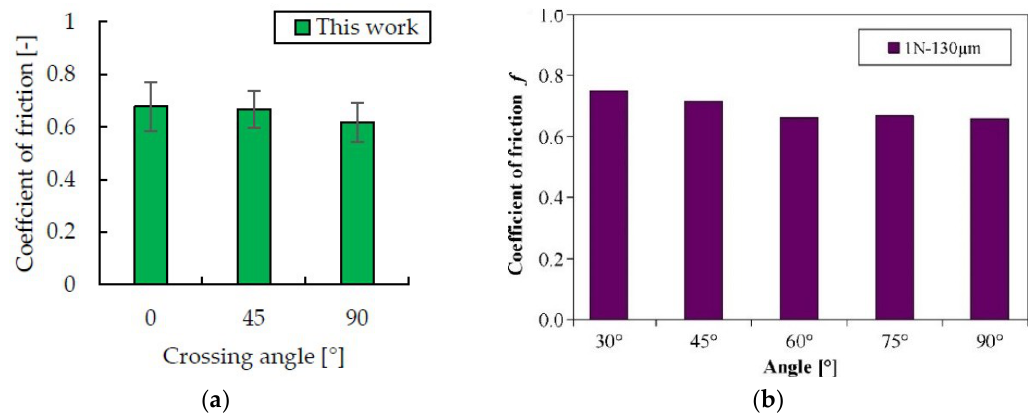
Figure 12. Coefficient of friction results: ( a ) CoF values for different crossing angles obtained in this work; ( b ) CoF values reported by Cruzado et al. [15] employing the same material but in fretting wear contact configuration in a tribometer developed by Klaffke [2] (Reproduced with permission from [2], Elsevier, 1985).